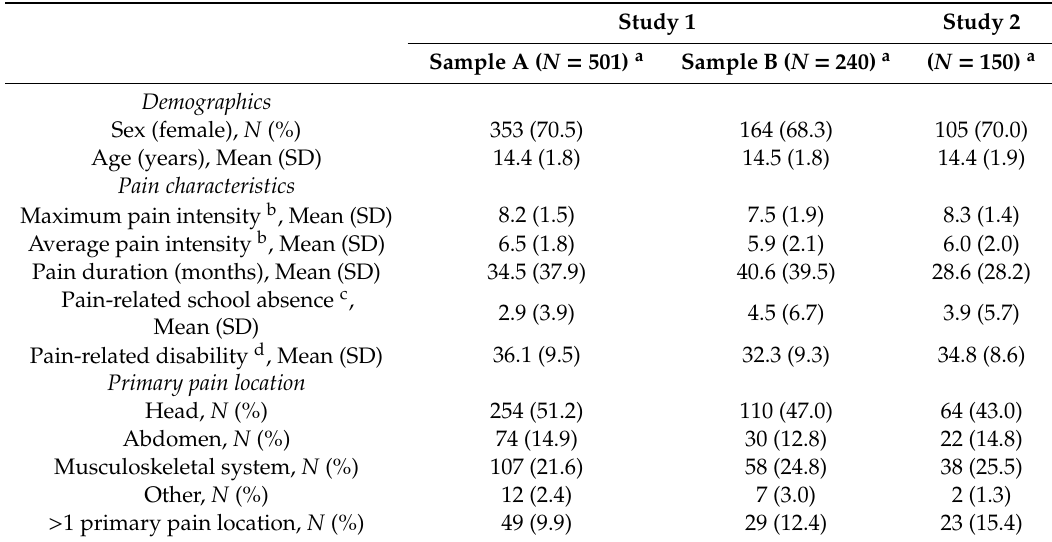
Table 1. Characteristics of the three adolescent study